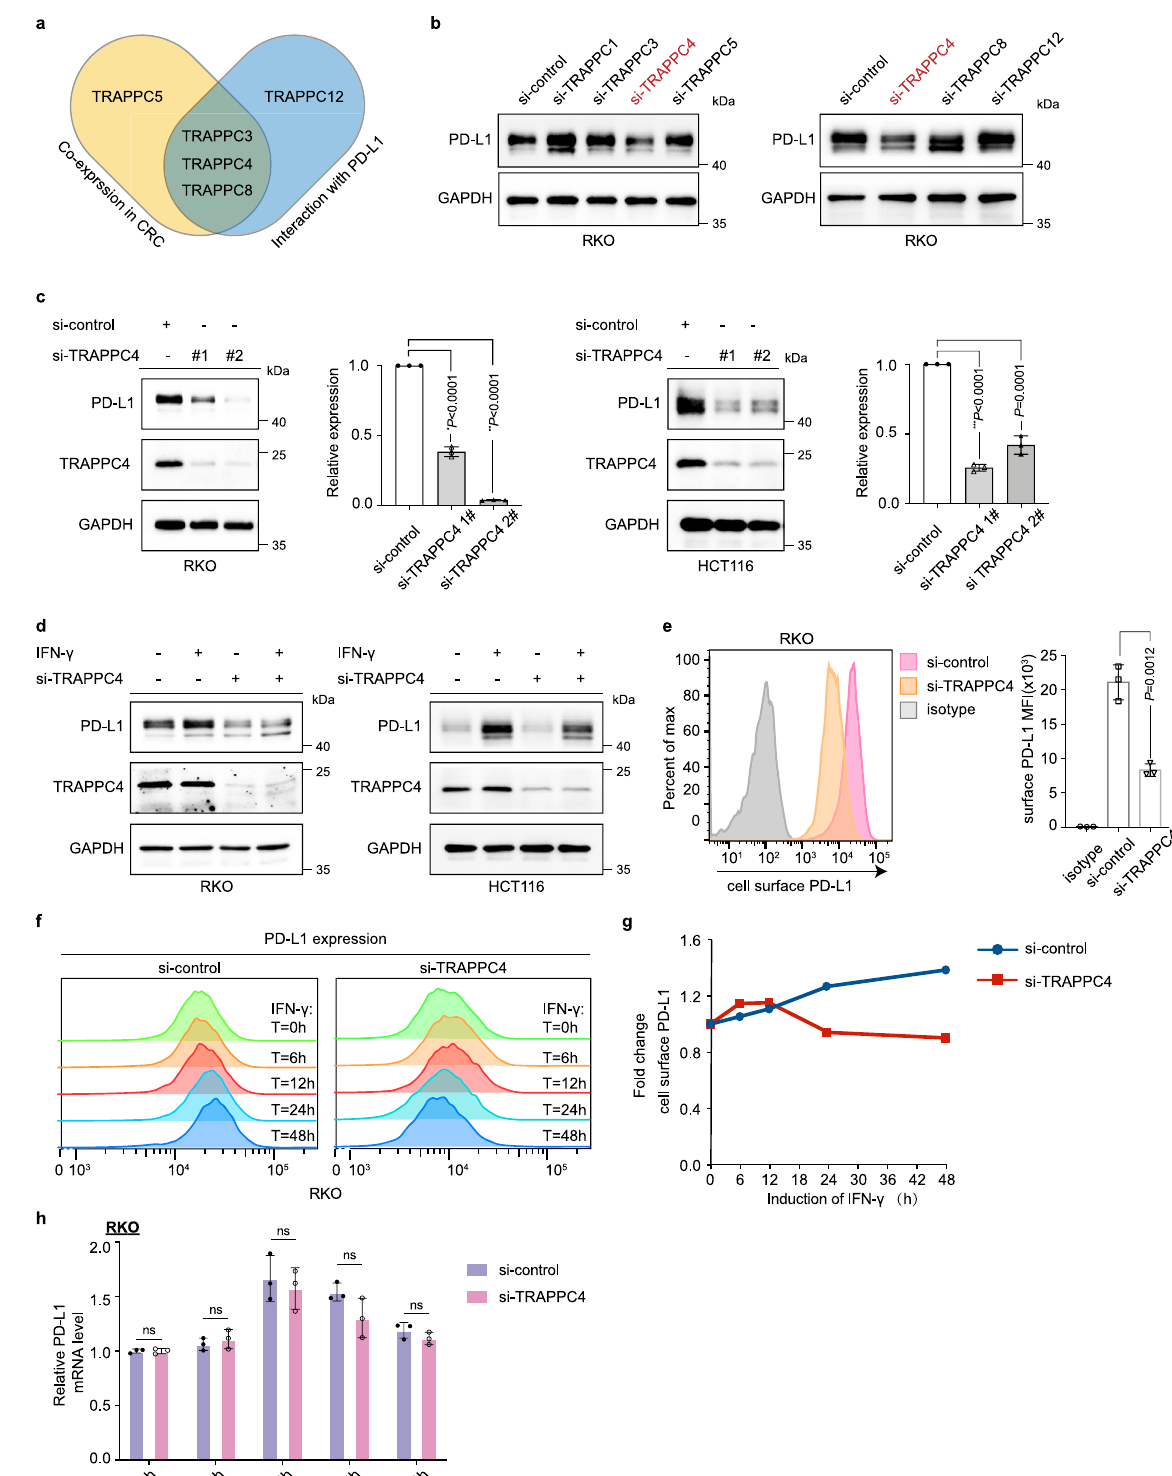
TRAPPC4 might play a regulatory role in the intracellular traf- fi cking of PD-L1. To verify this hypothesis, we fi rst set out to characterize the interaction between PD-L1 and TRAPPC4. Immunoprecipitation assays showed an interaction between endogenous PD-L1 and TRAPPC4 proteins in multiple CRC cell lines (Fig. 4a). Next, we introduced plasmids expressing FLAG-PD-L1 and MYC-TRAPPC4 into RKO and LoVo cells